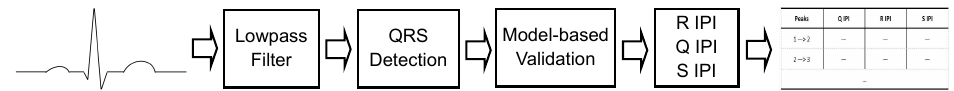
Figure 6. Steps of the digital processing: the ECG needs to be filtered, peaks are detected and validated. Output is a table of Q, R, and S